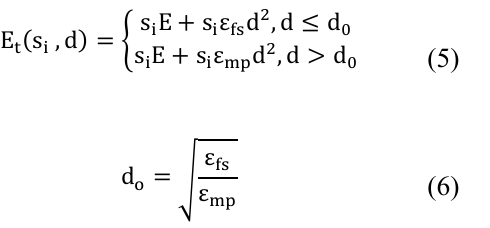
Algorithm 1: Cuckoo search algorithm for the data cluster head